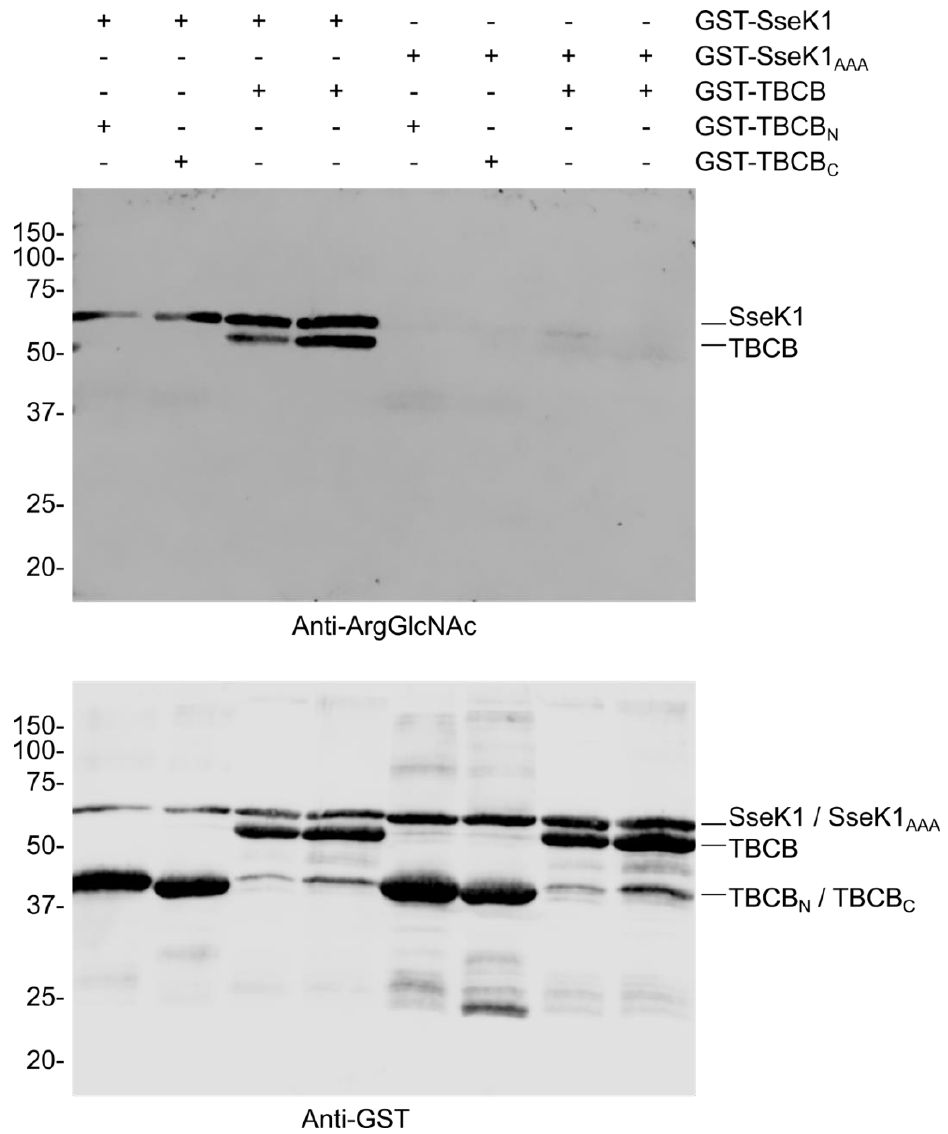
Figure 3. SseK1 glycosylates TBCB in vitro. Assay for SseK1 GlcNAc modification of TBCB using recombinant GST fusion proteins in the indicated combinations and 1 mM UDP-GlcNAc. SseK1 AAA : SseK1(D223A / D225A). TBCB N : N-terminal fragment of TBCB (amino acids 1–125). TBCB C : C-terminal fragment of TBCB (amino acids 126–244). A representative immunoblot is shown incubated with anti-Arg-GlcNAc (upper panel). The same blot reincubated with anti-GST was used as the loading control (lower panel). Molecular weights in kDa are indicated on the left.